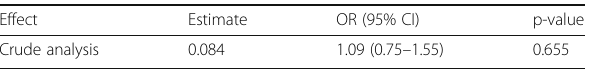
Table 2 (abstract 00138). Association between early hyperbilirubinemia and 30-day-mortality in patients with a normal platelet count ( ≥ 150 x 109 / L) (N = 3014)